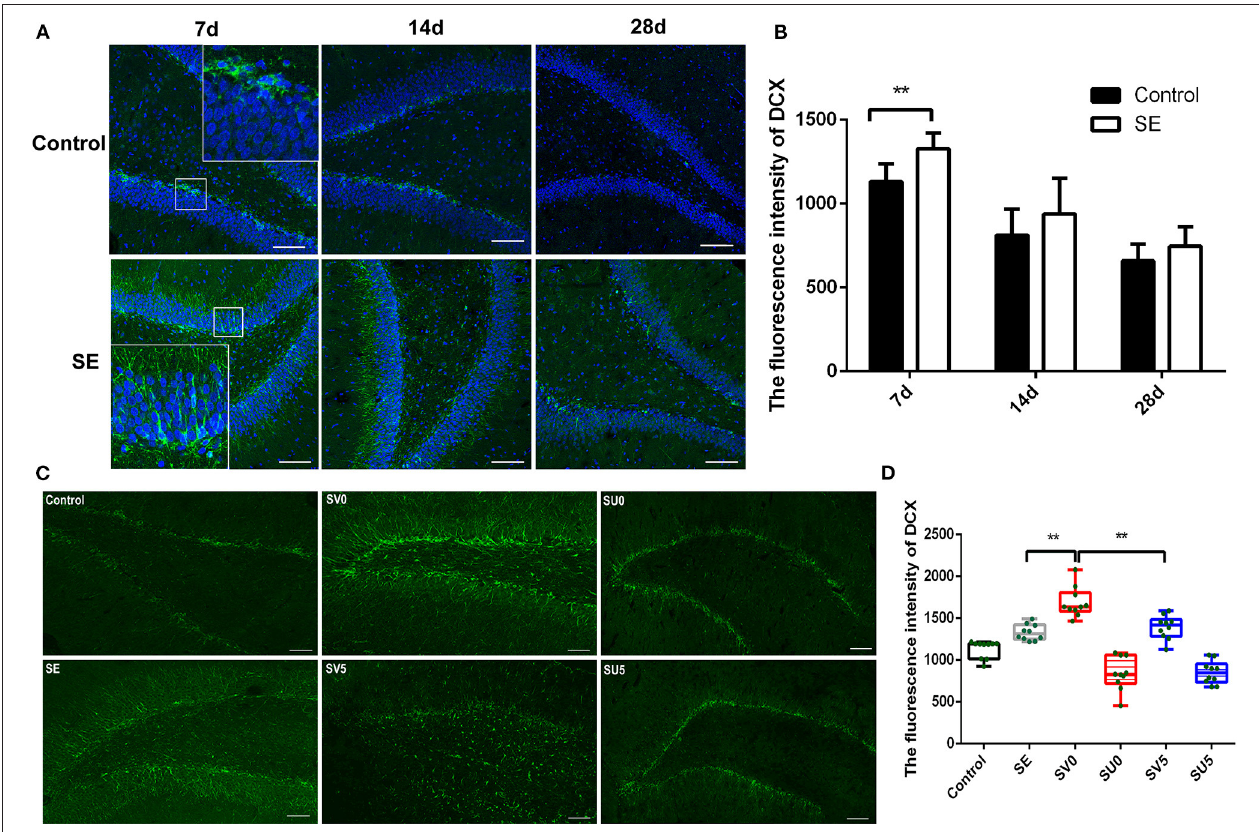
FIGURE 3 | The effect of VEGF on neurogenesis during epileptogenesis after SE (A) The immunofluorescence of DCX in the DG of the hippocampus after SE (Dcx: green; DAPI: blue; 200 × , scale bar: 100 µ m). (B) Dcx fluorescence intensity in the DG of the hippocampus after SE. The mean fluorescence intensity of DCX prominently increased at 7 days post SE compared to the control, ** P < 0.01. (C) Effect of VEGF-based interventions on neurogenesis in different phases after SE (SV, VEGF injection; SU, application of a VEGFR2 inhibitor. Dcx: green, scale bar: 100 µ m). (D) Dcx fluorescence intensity in the VEGF intervention groups in different phases after SE. Values were mean ± SD, ** P < 0.01, n = 5 for each